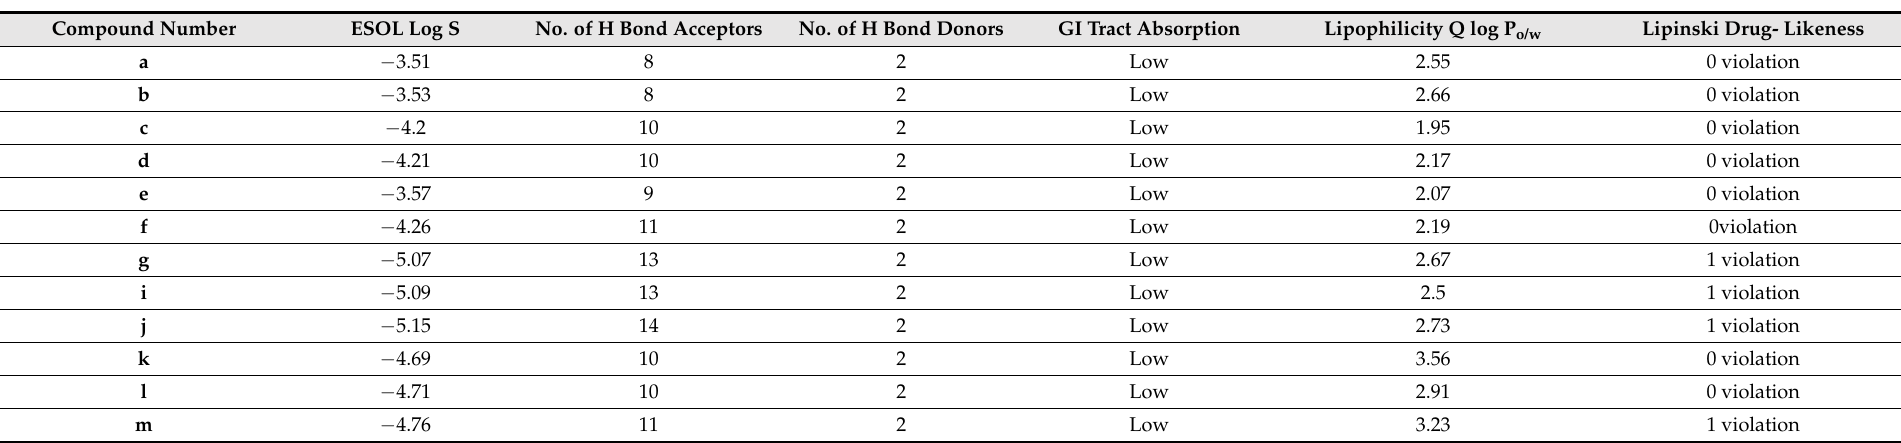
Table 8. SwissADME results of the predicted